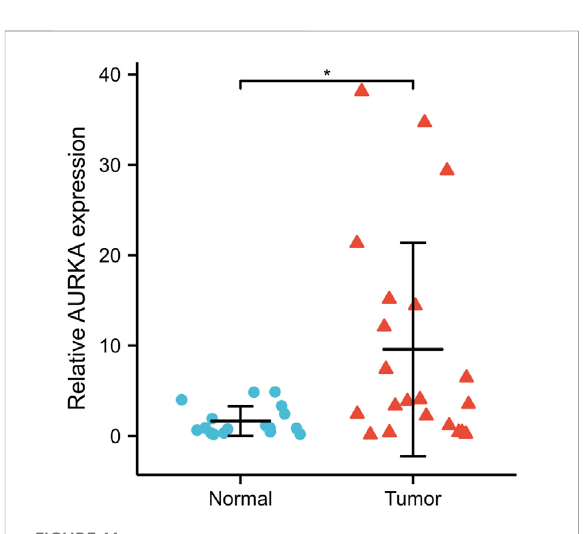
FIGURE 11 qRT-PCR validated AURKA expression in NPC tissue ( n = 21) and normal nasopharyngeal epithelial tissue ( n = 17). * p < 0.05. AURKA , Aurora kinase A; NPC, nasopharyngeal